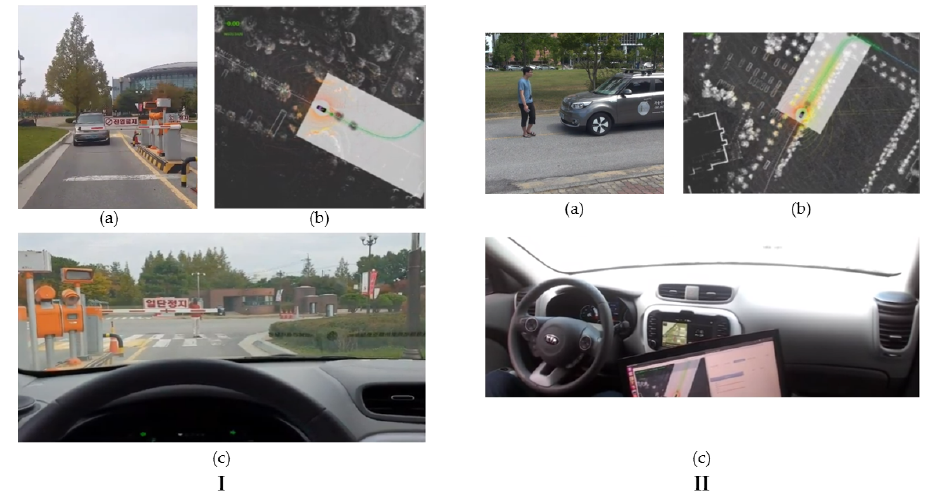
Figure 13. ( I ) ( a , c ) The autonomous vehicle is stopped in front of the obstacle. ( b ) The visualization of the process in the RViz showing the obstacle and the car. ( II ) ( a – c ) shows the results of an obstacle stop using the person as an obstacle (Best viewed in color).